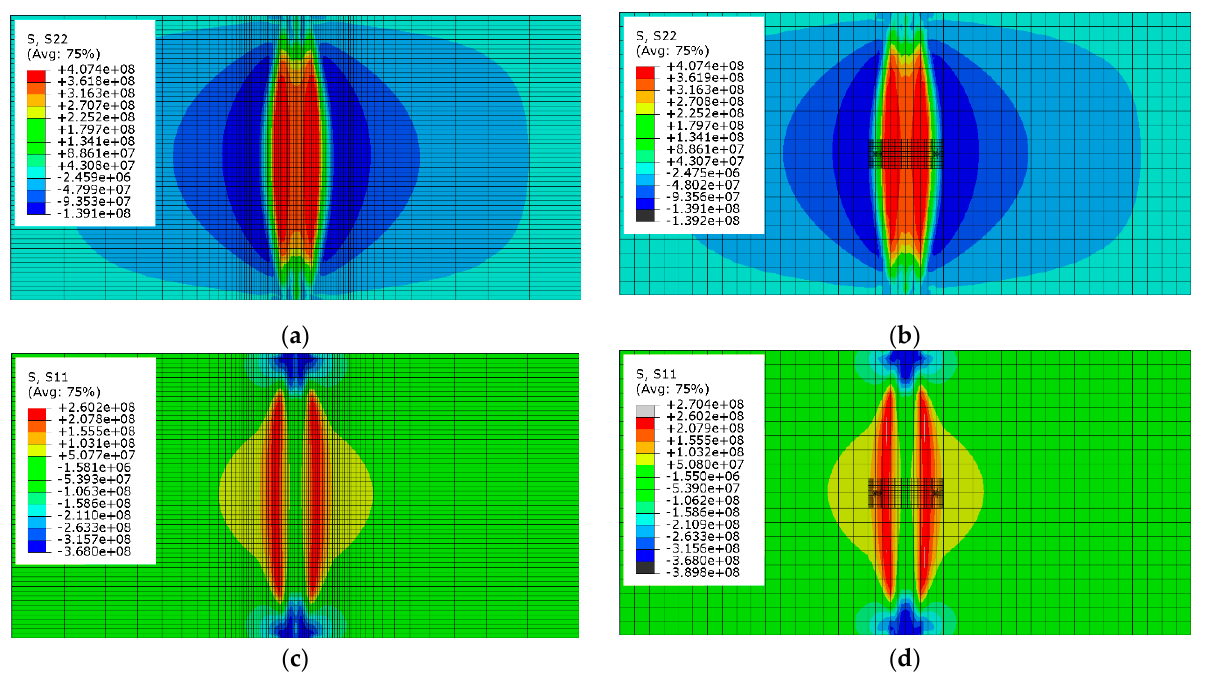
Figure 6. ( a ) Longitudinal stress after welding simulation, ( b ) longitudinal stress after mapping to mesh with closed crack, ( c ) transversal stress after welding simulation, ( d ) transversal stress after mapping to mesh with closed crack. All units are in (Pa).